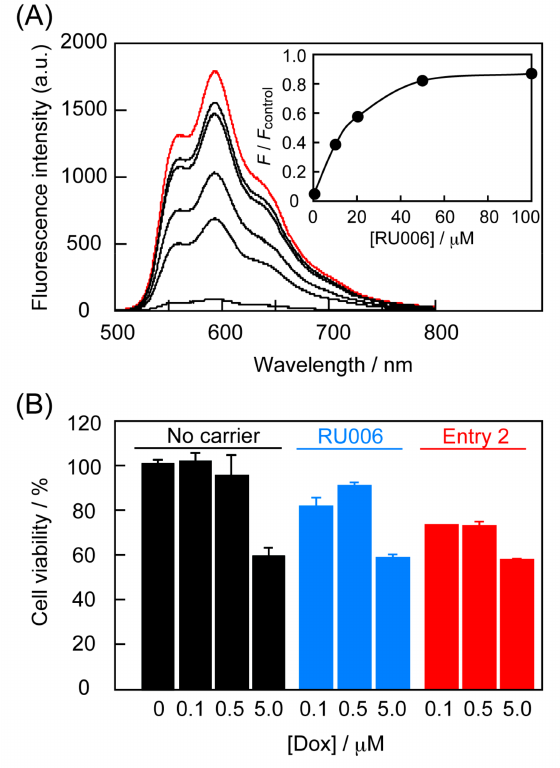
Figure 5. ( A ) Doxorubicin (Dox) encapsulation by RU006 carrier peptides as a function of RU006 concentration ([Dox] = 10 µ M and [RU006] = 0, 10, 20, 50, and 100 µ M in 20 mM sodium phosphate buffer, 150 mM NaCl, pH 7.2 at 25 ◦ C for 6 h) detected by fluorescence intensity from Dox ( λ ex = 480 nm) after ultrafiltration (COMW 100 kDa). Red line shows fluorescence emission from Dox without RU006 before ultrafiltration as a control. Inset shows relative fluorescence intensity of Dox-loaded RU006 peptide nanocarriers at 594 nm. F control indicates Dox fluorescence intensity for the red line in panel 5A; ( B ) Cytotoxicity (Dox-induced cell death) of Dox-loaded self-assembled peptide nanocarriers of Entry 2 for HeLa cells at 24 h after the reaction started (final peptide concentration = 50 µ M) (mean ± SD, n ≥ 3). Control experiments involved cell culture lacking both Dox and